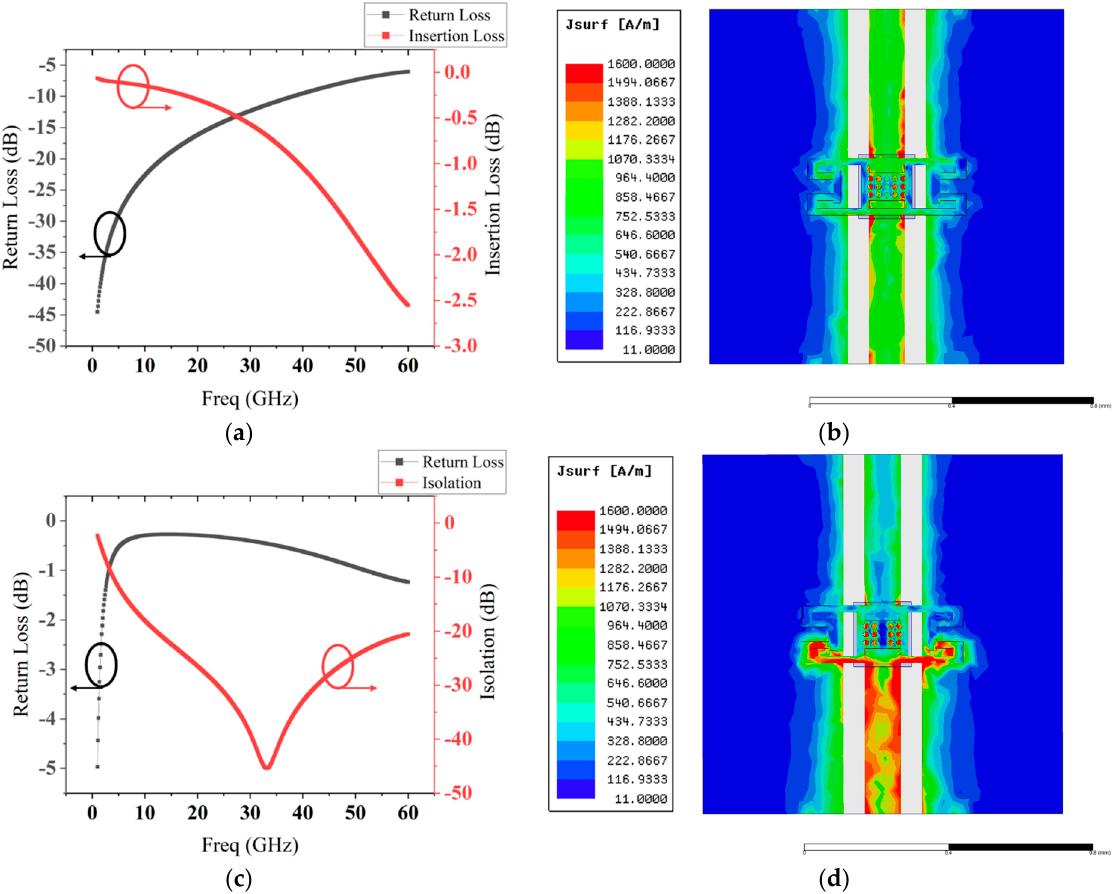
Figure 12. Simulated S parameters and current distribution diagrams: ( a , b ) up-state; ( c , d )